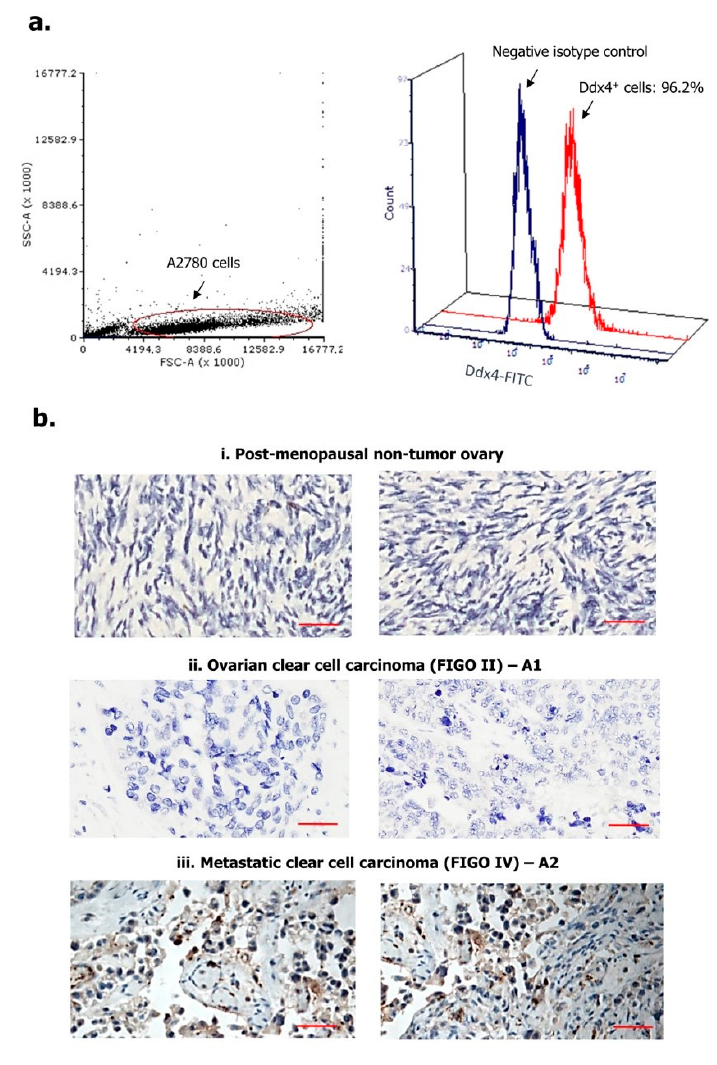
Figure 1. Expression of Ddx4 in A2780 cells ( a ) and ovarian samples ( b ). As a model of non-serous epithelial ovarian cancer (NS-EOC), A2780 cells were investigated by flow-cytometry, for the expression of Ddx4, after fixation and permeabilization ( a ). As shown, up to 96.2% of cells inside the gated region exhibited Ddx4 expression (Fluorescein Isothyocianate (FITC) signal). The antigen was also detected by Immunohistochemistry (IHC) in both healthy ovaries derived from post-menopausal women ( i ) and NS-EOC samples ( ii , iii ). Compared to the almost negative control samples in ( i ), representative panels from A1 ( ii ) and A2 ( iii ) patients exhibit higher Ddx4 expression, both in stromal and in cancer cells at the cytoplasmic level ( b ). In particular, the strongest staining intensity for Ddx4 was found in samples from patients included in the A2 group (International Federation of Gynecology and Obstetrics (FIGO) IV stage, n = 2), while moderate ( ++ ) to weak ( + ) scores occurred in A1 (FIGO I-II, n = 2). Scale bars = 50 µ